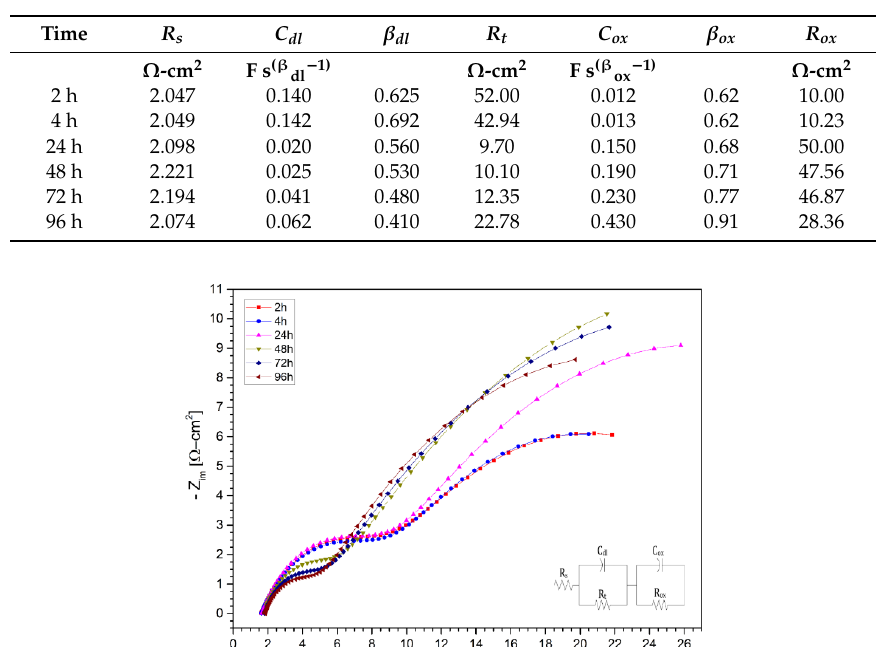
Figure 11. Nysquist diagram of stainless steel 430 layer in (LiNaK)NO 3 (ternary salt with lithium content) at 2 h, 4 h, 24 h, 48 h, 72 h, 96 h at 550 °C. Table 7. Fitting results of the impedance spectra of stainless steel 430 during corrosion in the presence of (LiNaK)NO 3 (ternary salt with lithium content) at 550 °C.